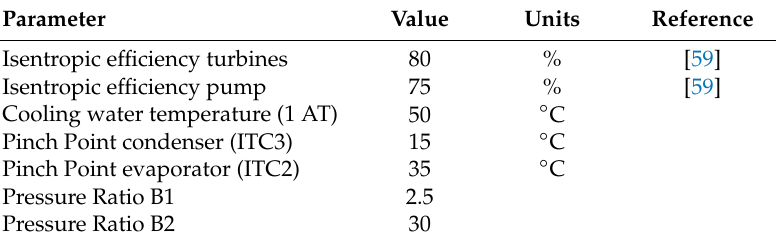
Table 5. Parameters considered for the proposed